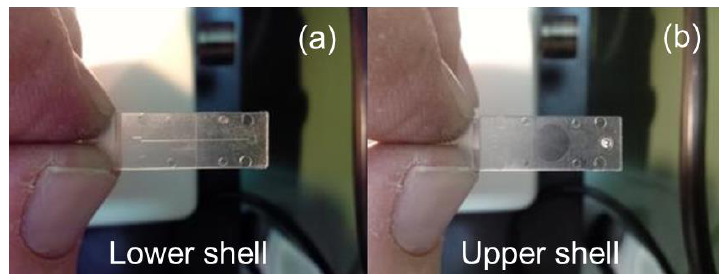
Figure 8. PMMA lower ( a ) and upper shells ( b ) of the Lab-on-chip prototype.